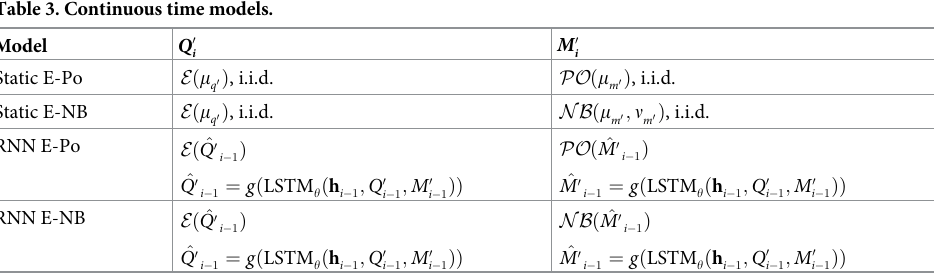
Table 3. Continuous time models.